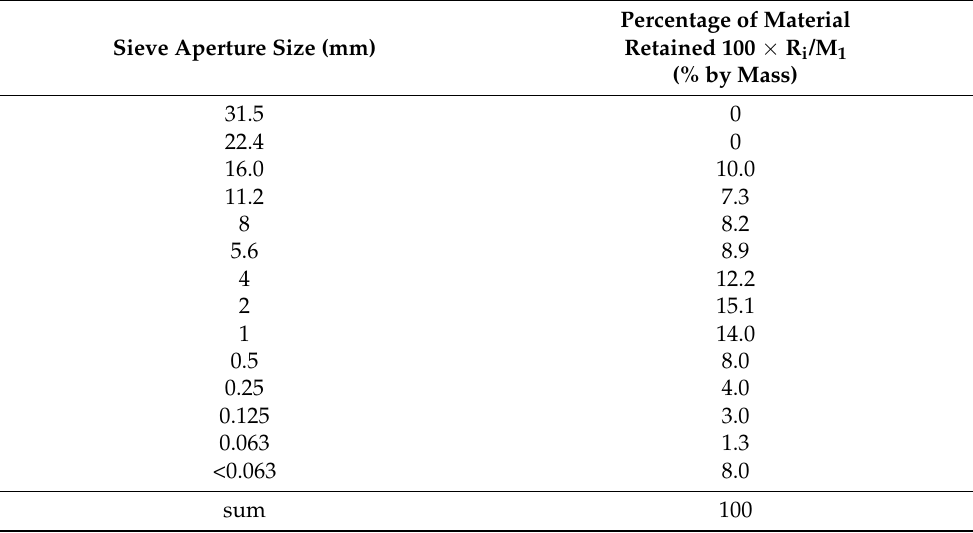
Figure 6. Particle size distribution of reclaimed aggregate (RA) used in the mixture. Table 7. Grading of reclaimed aggregate (RA) used in the mixture.